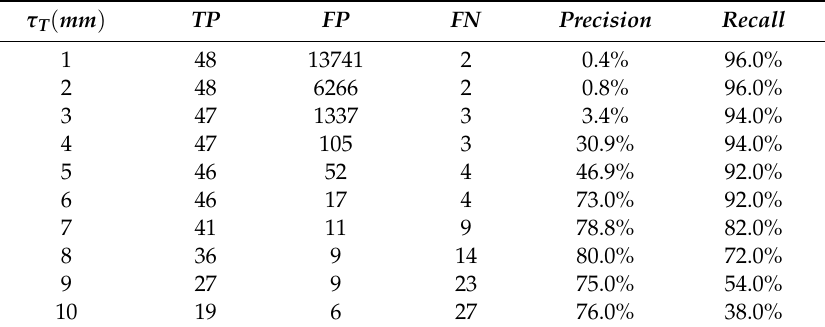
Table 3. Variation of precision and recall with the threshold τ T